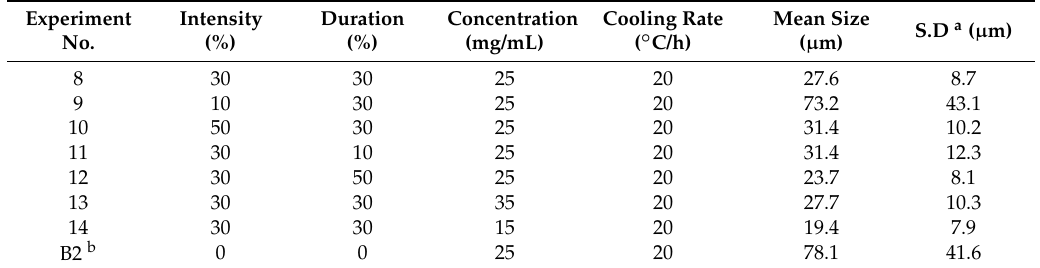
Table 3. Data for the synthesis and crystallization of N ′ -(propan-2-ylidene)-isonicotinohydrazide. Experiment No.